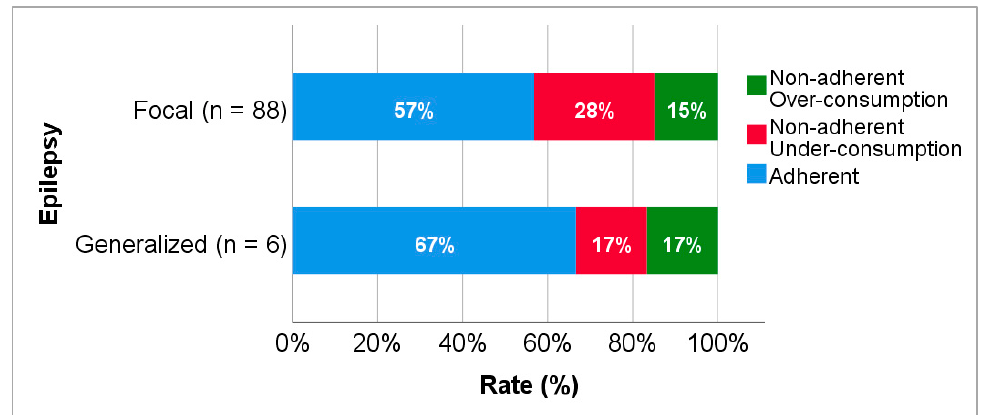
Figure 3. Adherence to levetiracetam treatment according to type of epilepsy.